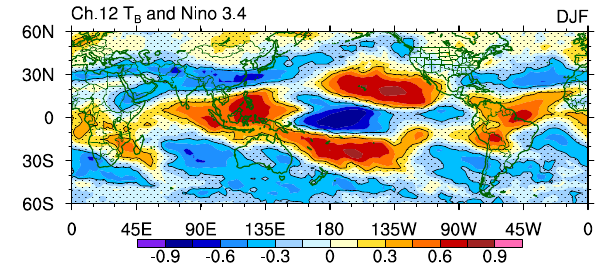
Fig. 8. Same as Fig. 7 for correlations between channel 12 T B and PDO